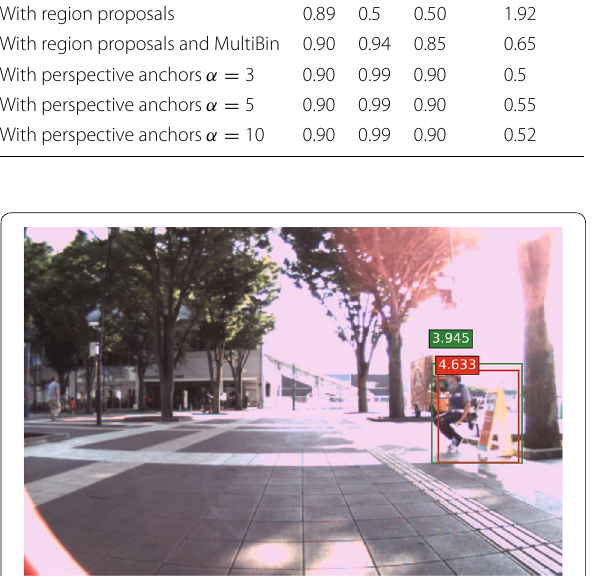
Fig. 18 Examples of estimated distance for the side-view of the target object in Tsukuba Challenge. The ground truth distance and estimated distance are written in green and red boxes respectively. The unit is in